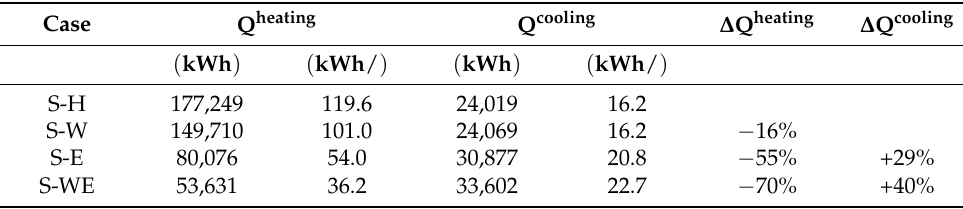
Table A2. Results of the simulations: annual energy demand for heating and